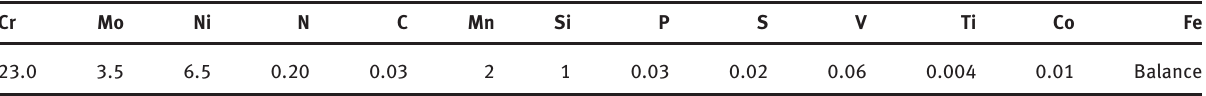
Table 1: Chemical composition of Duplex SS 2205 (in wt%).